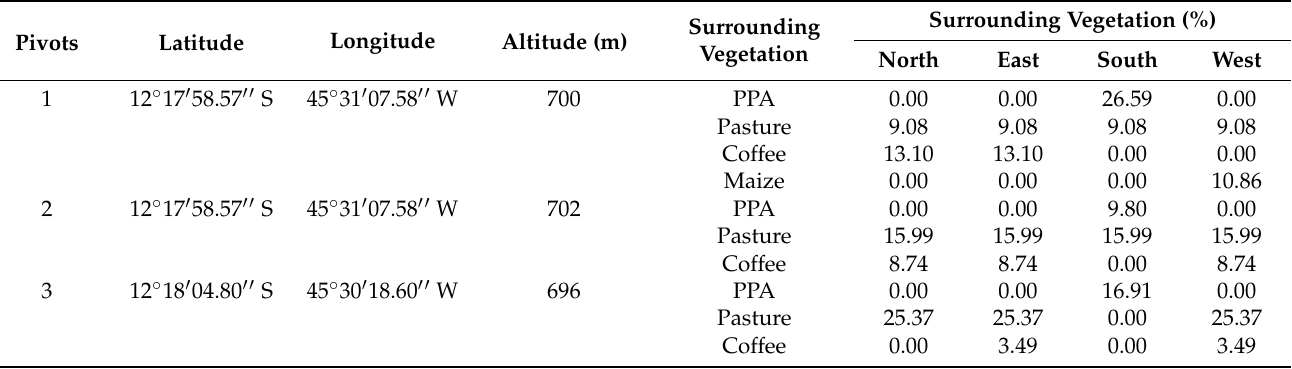
Table 1. The geographical location of each pivot of the coffee plantation and the composition of the surrounding vegetation of each